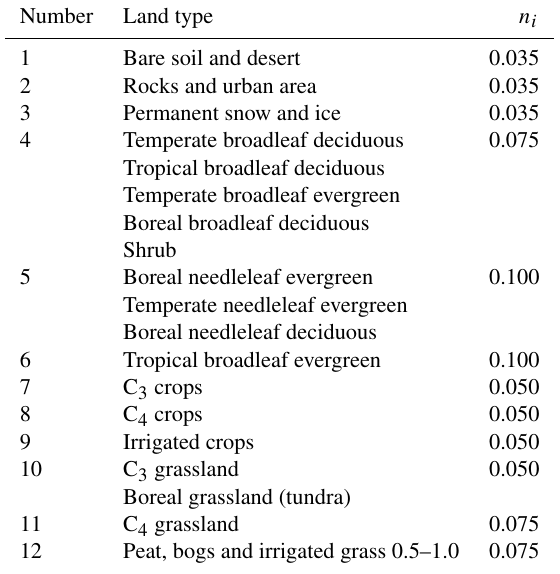
Table 1. The 12 land types derived from the 1km ECOCLIMAP-II database and their corresponding Manning roughness